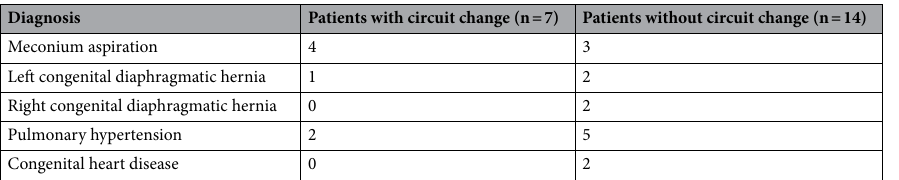
Table 2. Patients’ diagnoses (n = 21). There was no statistically significant risk related to diagnosis and circuit change risk.